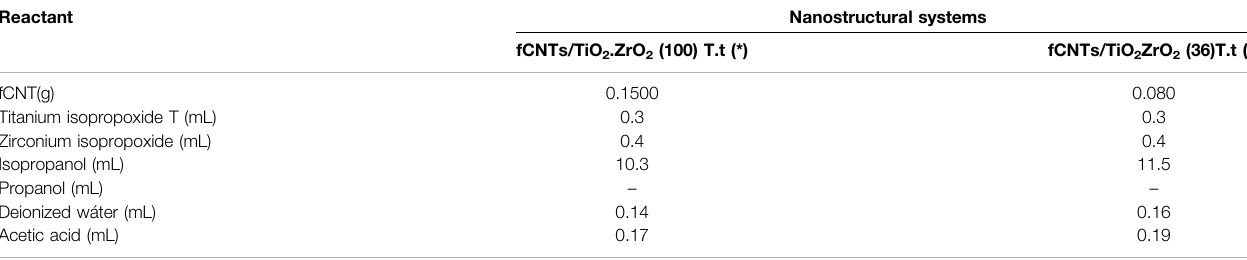
TABLE 1 | Amount of reactants used in the synthesis of the nanostructured materials fCNT/MO 2